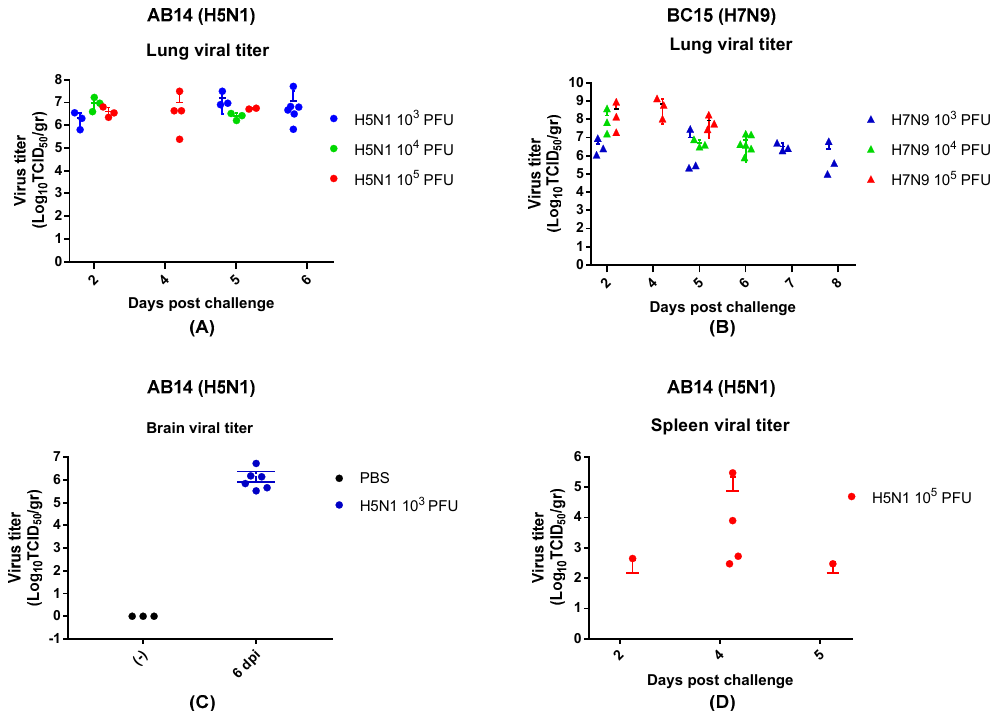
Figure 3. Viral titration of the mouse lung, spleen, and brain for the AB14 (H5N1) and BC15 (H7N9) strain isolates. Mice were intranasally infected with 10 3 PFU, 10 4 PFU, or 10 5 PFU of AB14 (H5N1) or BC15 (H7N9). The lung, spleen, and brain tissues were collected and homogenized for virus titration by TCID 50 assay. Lung viral titration from ( A ) AB14 (H5N1) and ( B ) BC15 (H7N9) infection for all doses. Brain viral titration from ( C ) AB14 infection (H5N1). Spleen viral titration from ( D ) AB14 (H5N1) infection. Please note that BC15 (H7N9) was not detected in the spleen and brain of mice infected by all three doses.